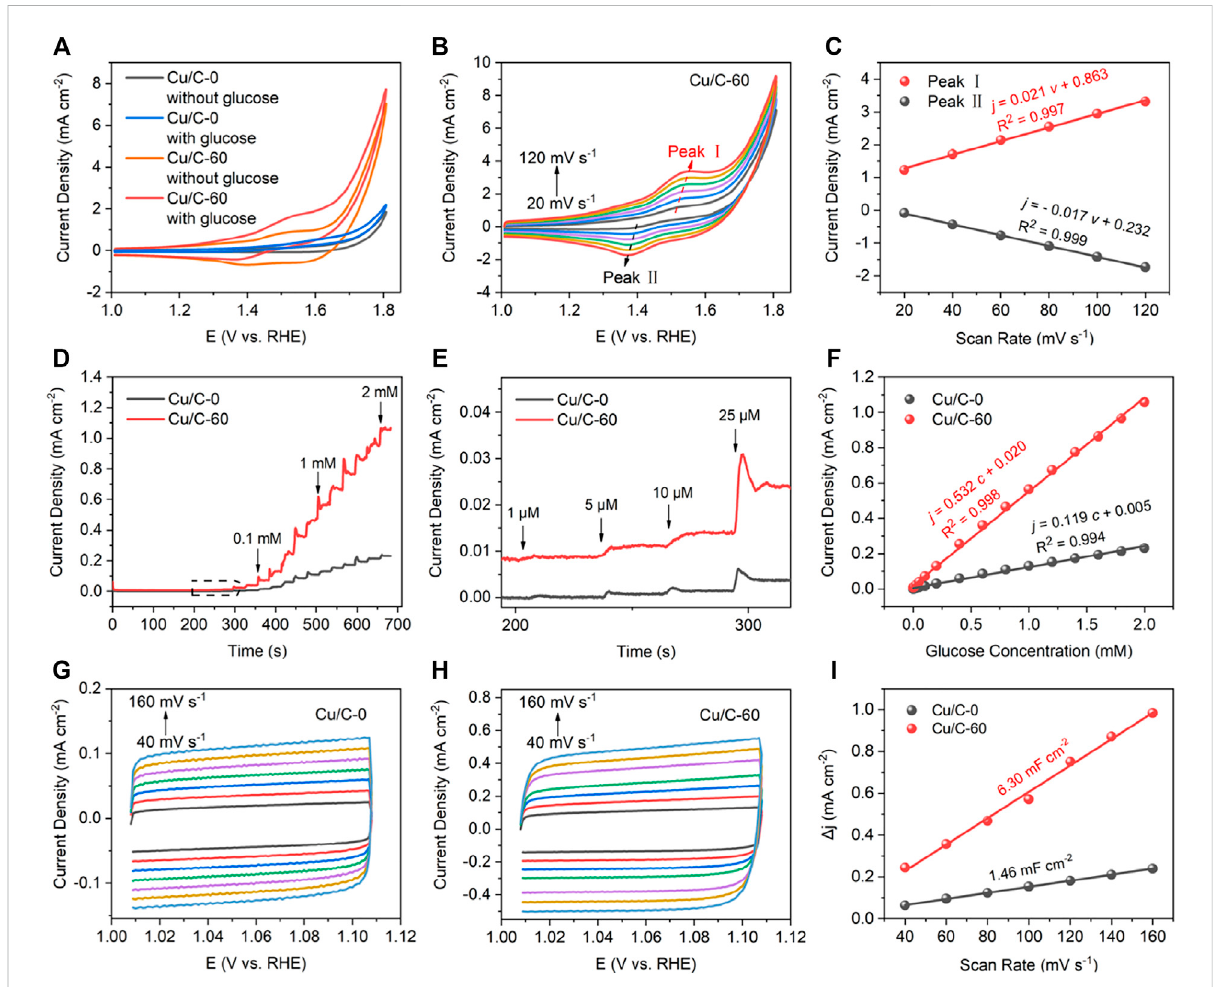
FIGURE 2 (A) CV curves obtained without glucose and with glucose (1 mM) at a scan rate of 40 mV s − 1 . (B) CV curves for Cu/C-60 obtained with 1 mM glucose at different scan rates. (C) Peak current densities of Peaks I and II in (B) as function of scan rates. (D,E) Current densities as function of times, with (E) being the enlarged drawing for the contents marked by dotted box in (D) . (F) Current densities as function of glucose concentrations. (G,H) CV curves in the non-Faradaic region at different scan rates, with (G) for Cu/C-0 and (H) for Cu/C-60. (I) Changes in current densities as functionofscanratesinthenon-Faradaicregion.Theglucoseconcentrationshowninthe fi guresarethetotalglucoseconcentrationinthereaction